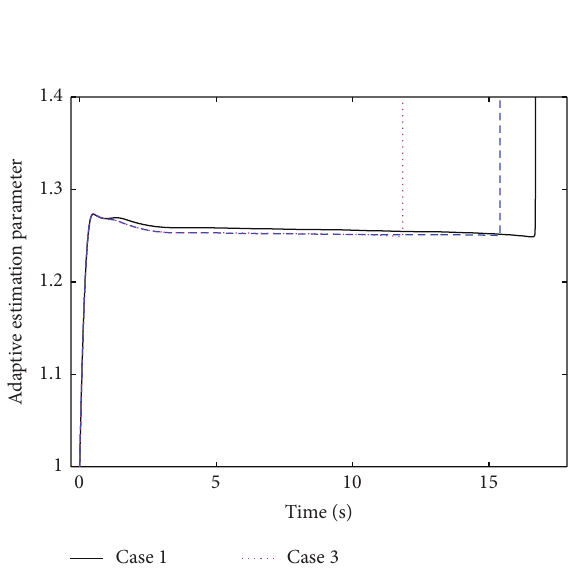
Figure 16: Missile acceleration (Case 3).